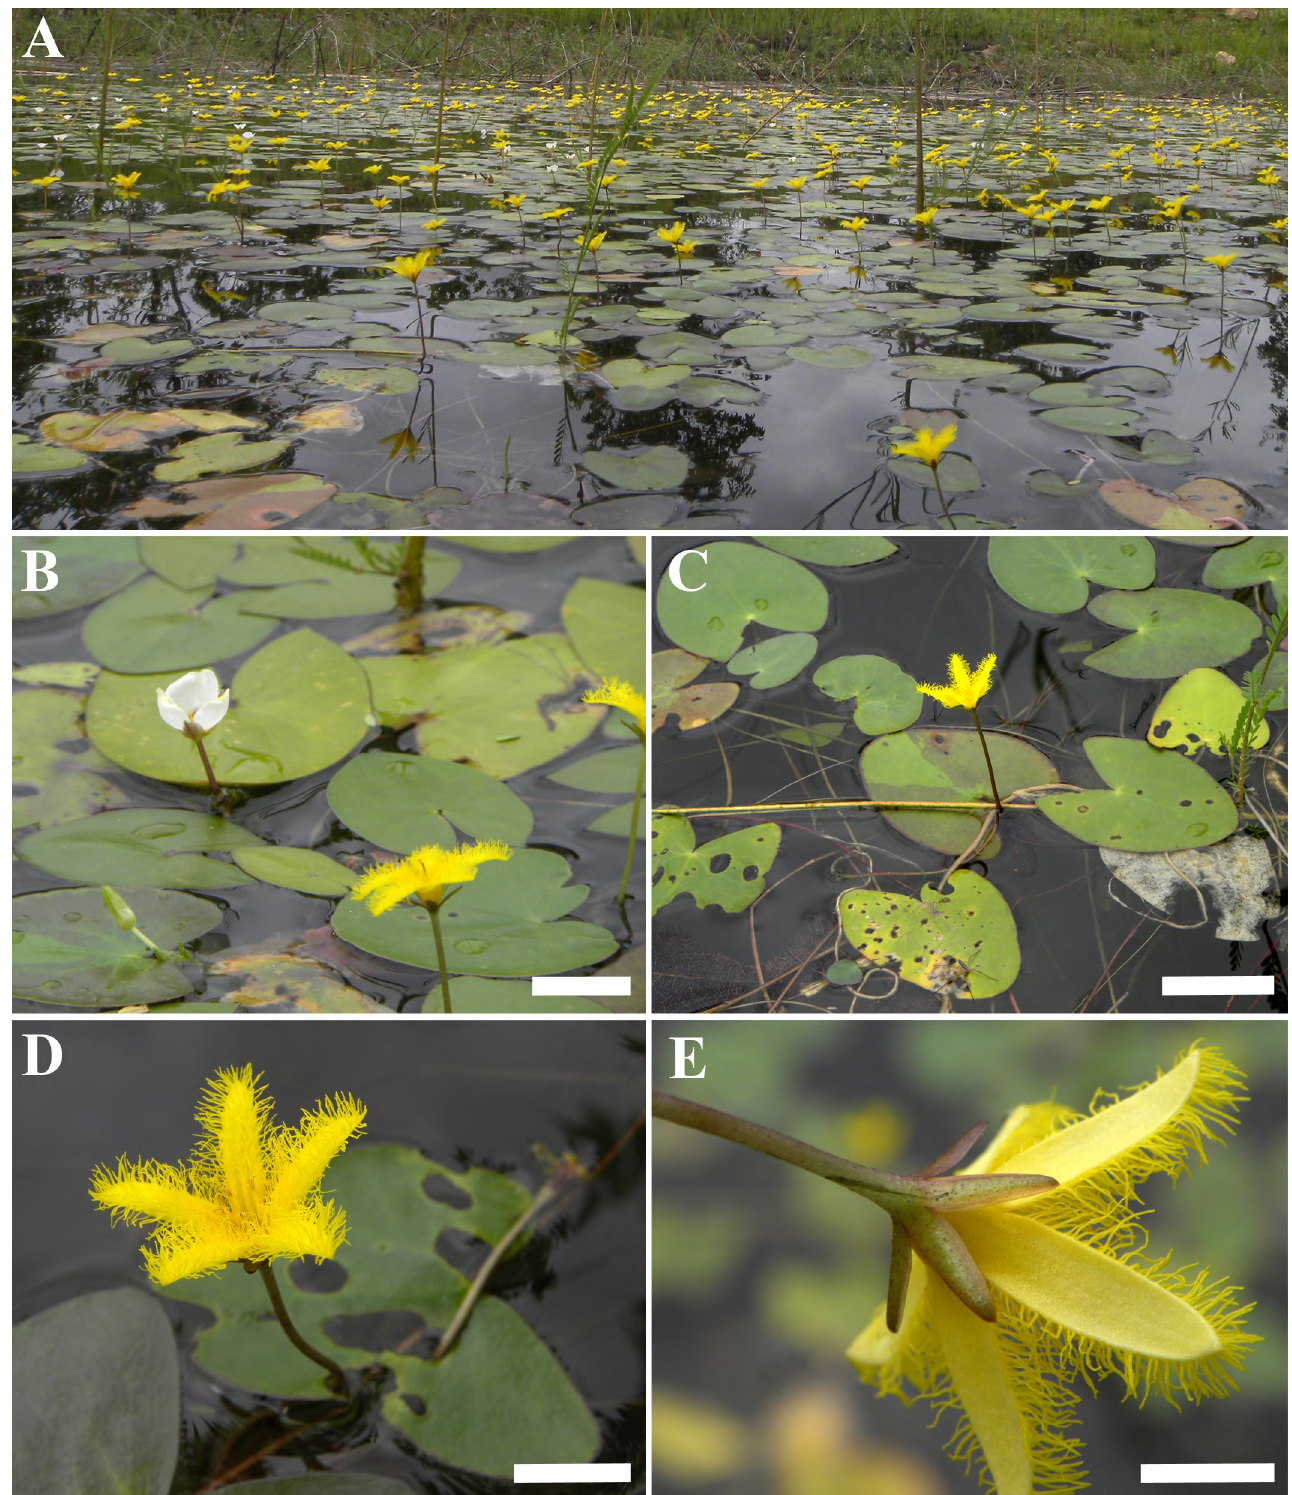
Figure 1. Nymphoides grayana N. grayana N. grayana (Griseb.) Kuntze (Menyanthaceae) in its natural environment in the municipality of Conceição do Tocantins, Brazil. A) Pond with a population of ; B) near a : C) Habitus (scale bar = 3cm); D) Front view of the flower (scale bar = 1cm); E) Rear view of the flower (scale bar =